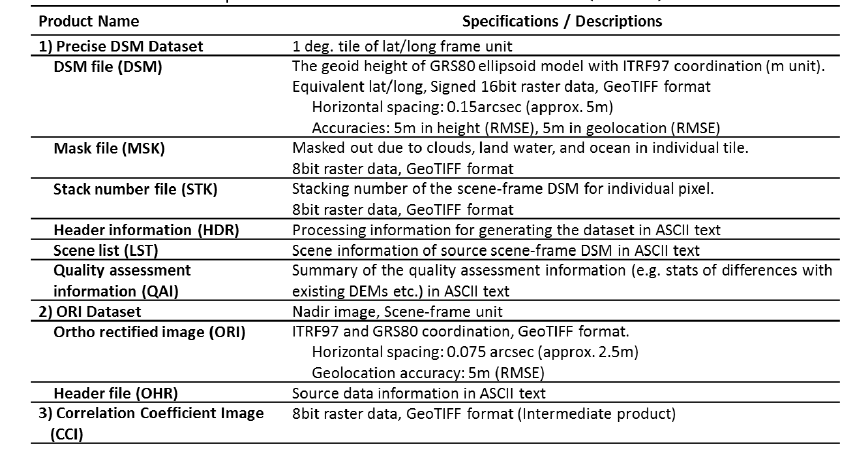
Figure 2. The status of PRISM stereo scenes in the archive with < 30% cloud cover. Table 2. Specifications of the “ALOS World 3D” (AW3D) dataset.